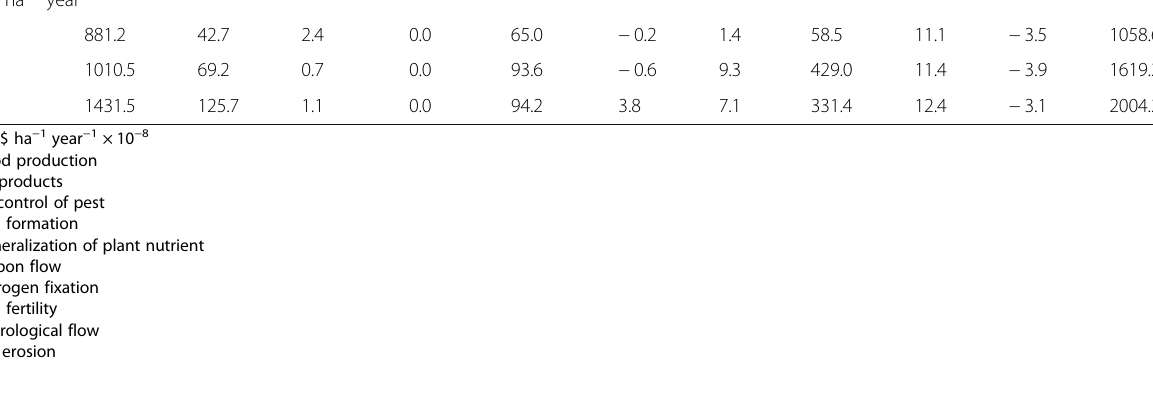
Table 6 Quantitative PCA representatives Cluster